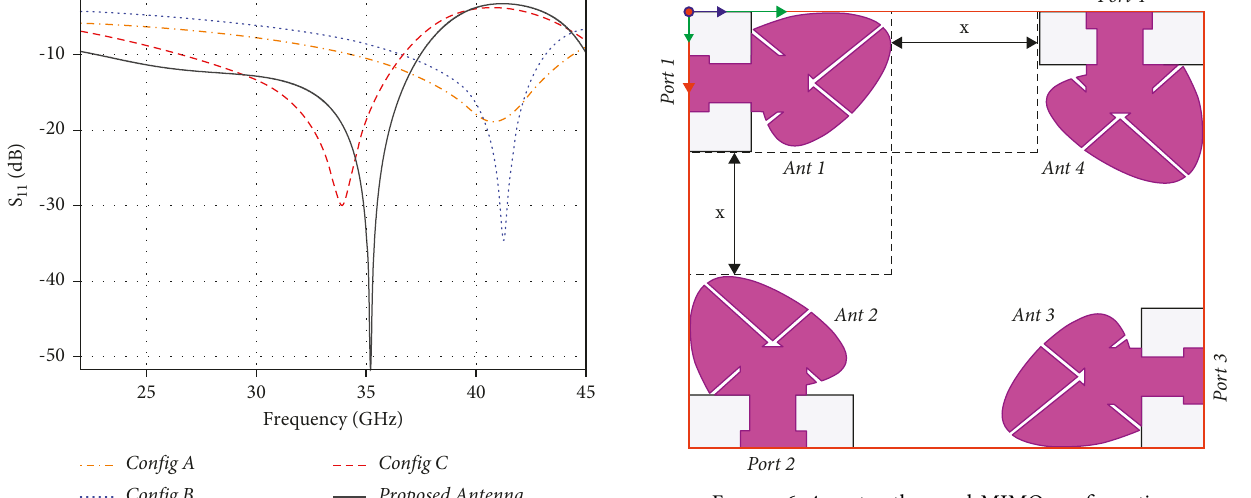
Figure 6: 4 port orthogonal MIMO configuration.